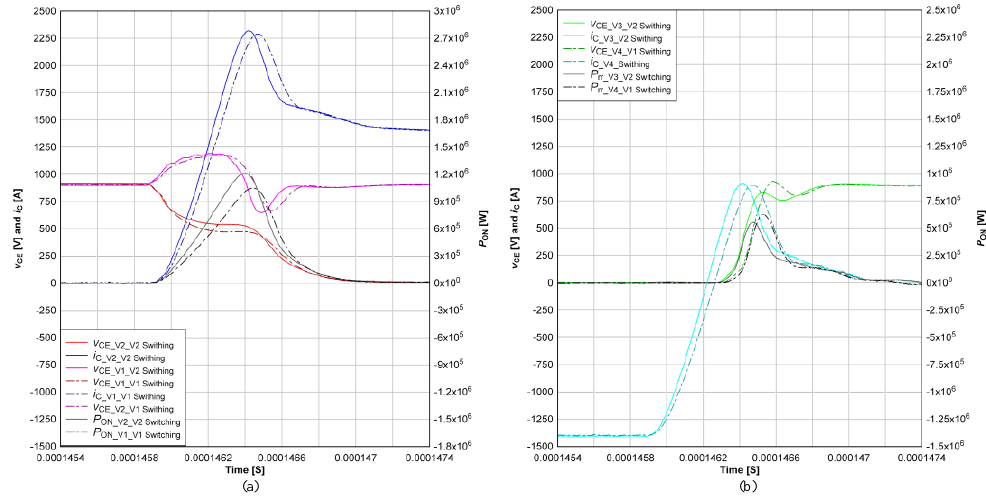
Figure 25. Influence of the stray inductance during IGBT turn-on at 0.9 kV and 1.4 kA (T vj = 25 °C, V GEon = −15 V, and R Gon = 0.9 Ω). ( a ) Detail waveforms through IGBT. ( b ) Detail waveforms through FWD.